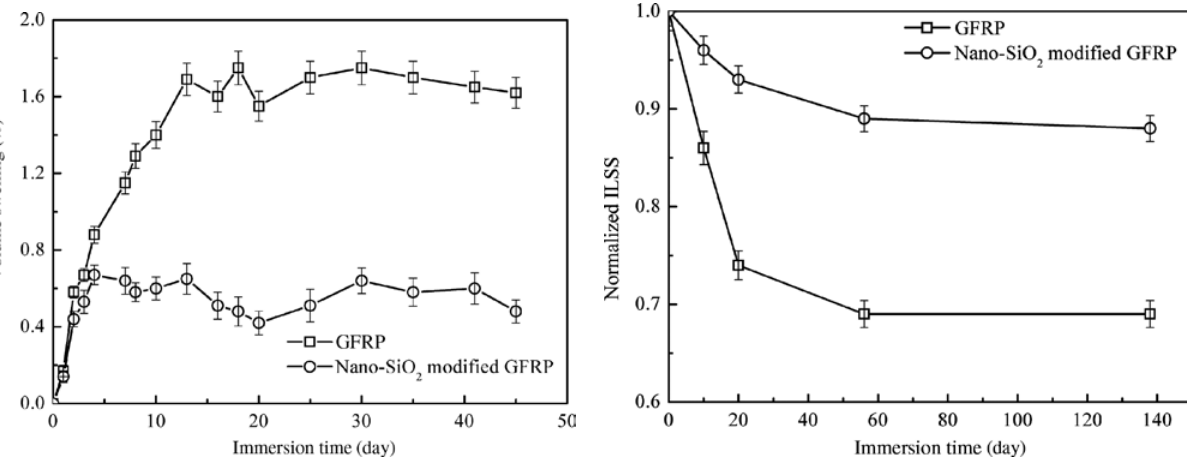
Figure 8: Normalized ILSS as a function of the immersion time for the GFRP